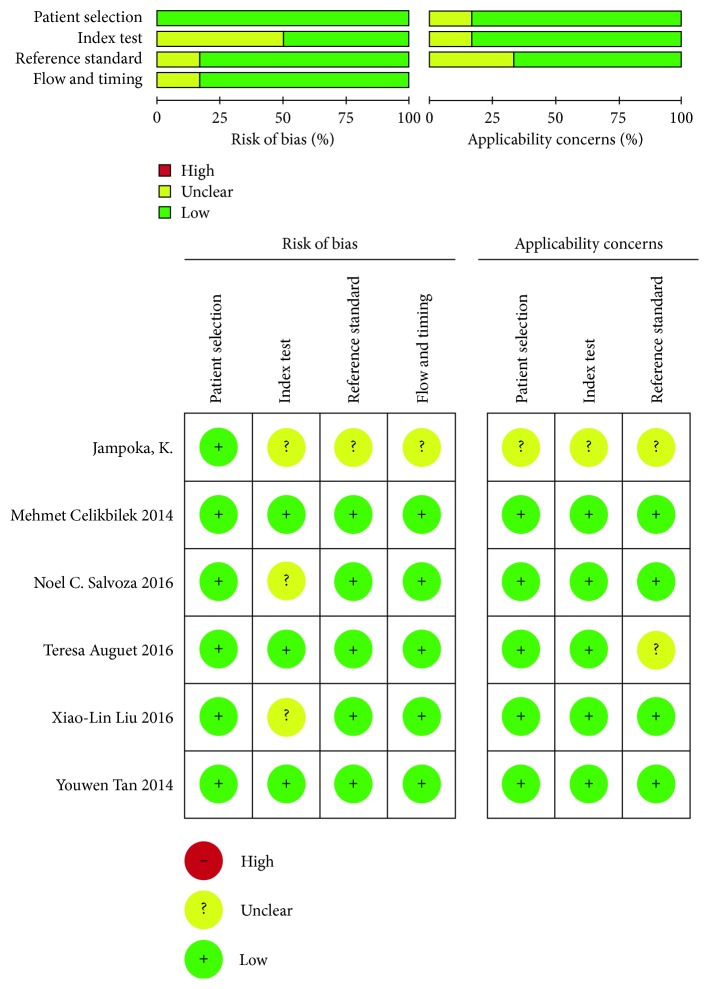
Overall methodology quality assessment of included articles using the QUADAS criteria.